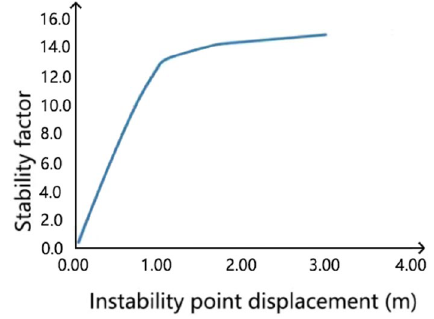
Figure 10. The load–displacement curve of the elastic buckling state.